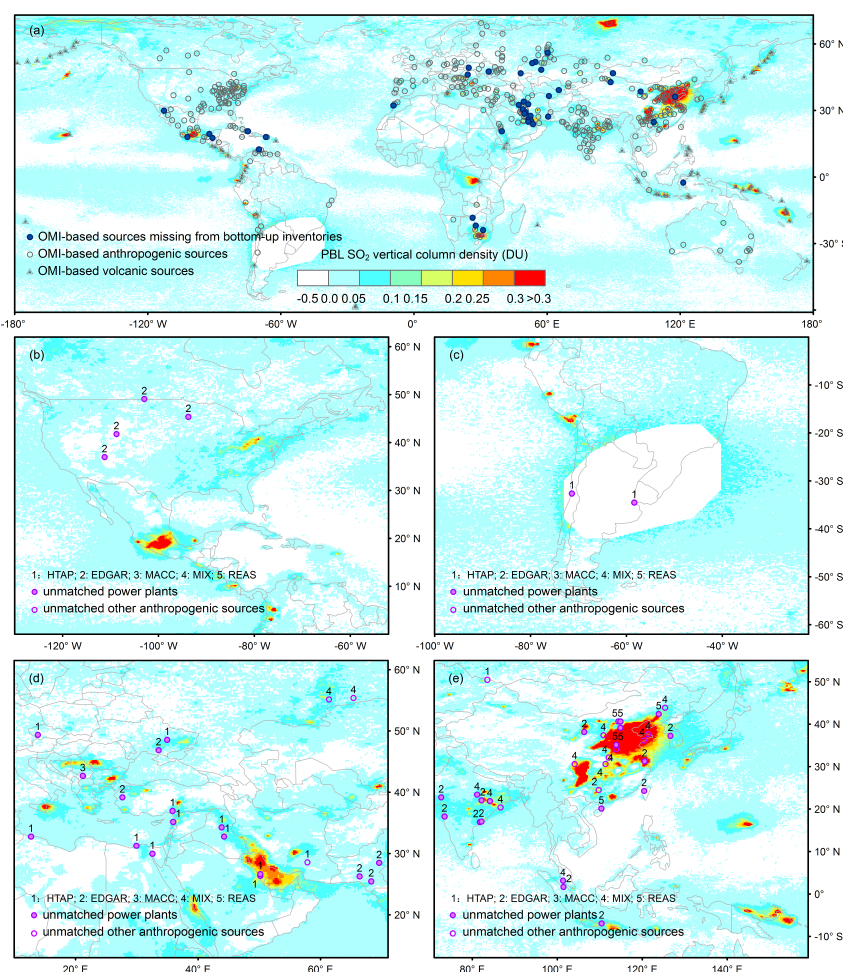
Figure 8. (a) Geographic distribution of SO 2 sources in the OMI-based emission catalogue (Fioletov et al., 2016). SO 2 sources identified that were found to be missing from bottom-up inventories are in blue. Locations of large sources indicated by bottom-up inventories but not detected by OMI (unmatched) over (b) North America, (c) South America, (d) Europe, and (e) Asia. The background is the global mean SO 2 distribution (in DU) map for 2005–2014. The area affected by the South Atlantic Anomaly is shown as a white